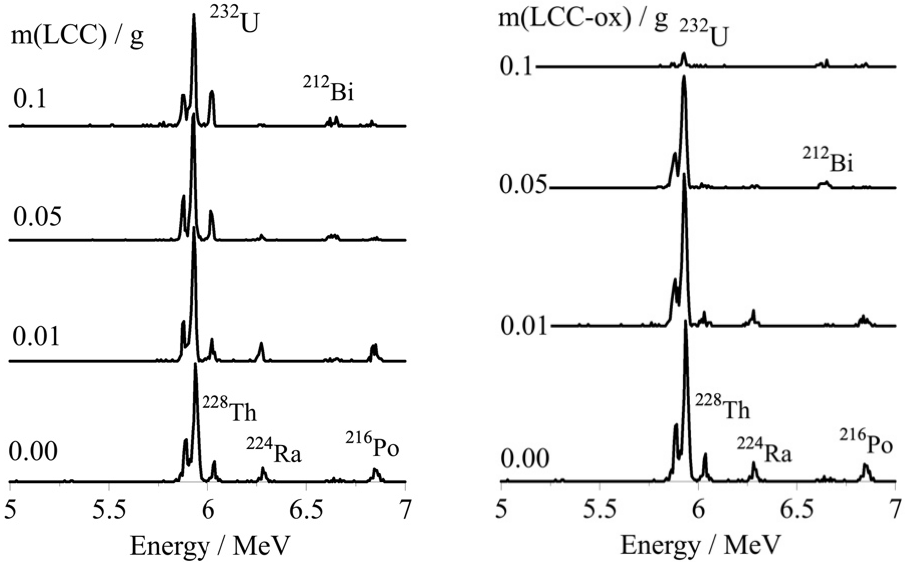
Figure 3. The alpha spectra of the U-232-traced aqueous solutions after treatment with different masses of unmodified (m(LCC) in g) and oxidized biochar (m(LCC_ox) in g). [U-232] = 8.6 × 10 − 14 mol/L, pH 4 and ambient conditions. It has to be noted that Bi-212, Ra-224, Th-228 and Po-216 are daughter nuclides of U-232 and are therefore present in the alpha spectra.